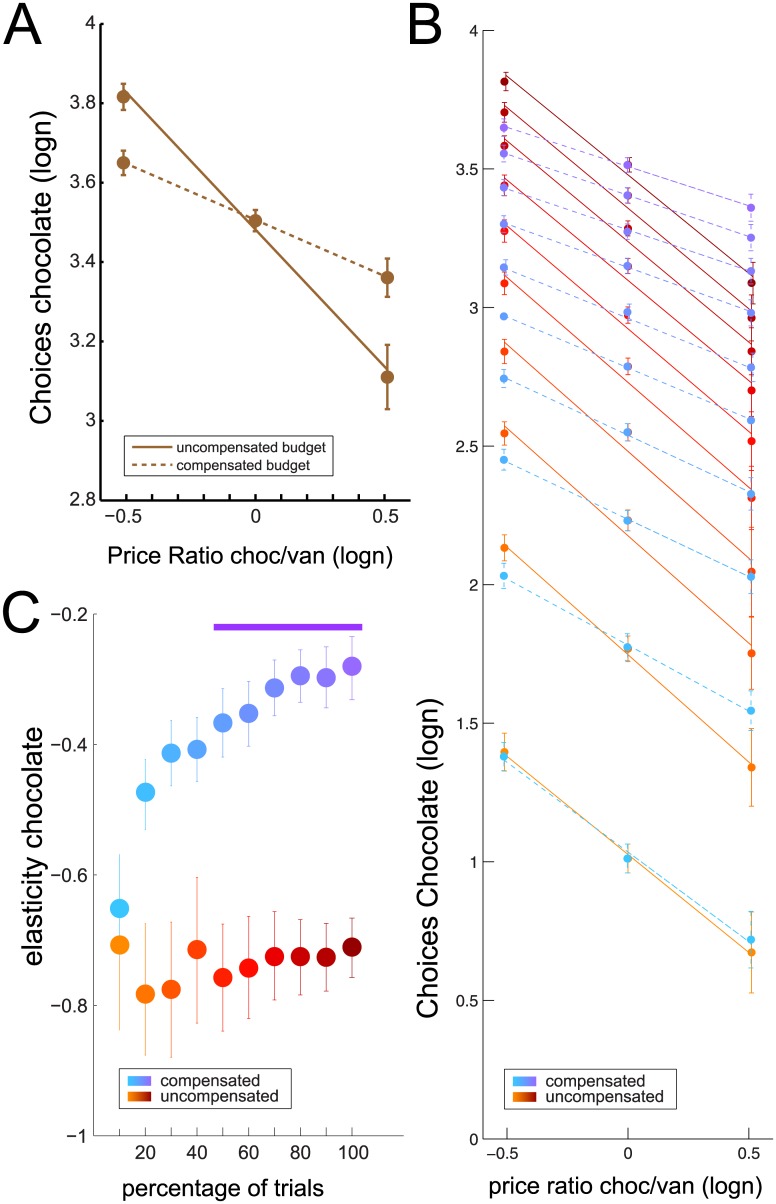
Demand elasticity for chocolate over entire and cumulatively spent budgets A) Scatterplot of log-transformed choices for chocolate (mean ± SEM across rats) by log-transformed price-ratios (chocolate/vanilla) for uncompensated (solid line) and compensated budget conditions (dashed line).Please refer to Fig 3 for significance of the differences. B) as in A), but now displaying log-transformed number of chocolate choices calculated over 10 cumulative steps of 10% of the entire budget. Colour coding indicates percentage of budget considered: from yellow to brown (solid lines): 10–100% of budget in the 5:3 condition; from blue to purple (dashed lines): 10–100% of budget in the 5:3C condition. C) Elasticity estimates for the chocolate choice data shown in B) with cumulative uncompensated budget fractions in hot colors, and cumulative compensated budget fractions in cool colors. Error bars: SEM. Purple bar: significant difference incremental paired sample t-test (1st time point: p<0.05, 2nd time point p<(0.05/2), 3rd time point p<0.05/3 etc.; see text for details).